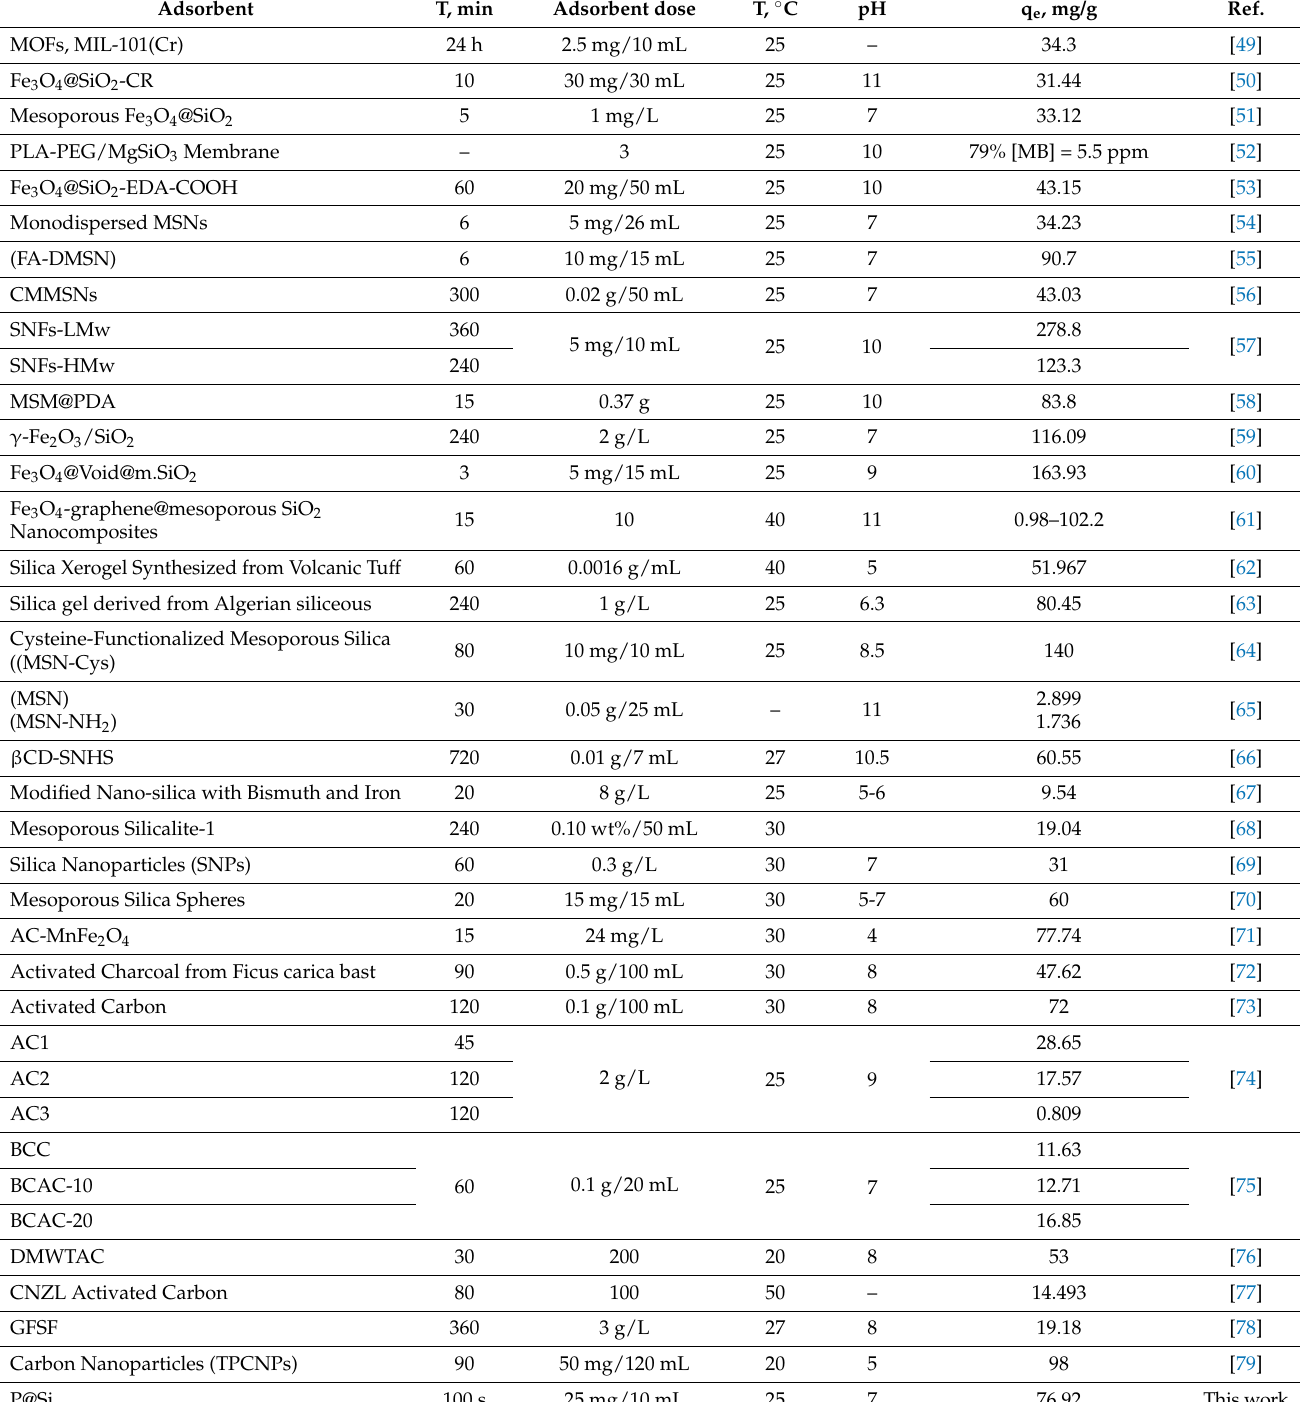
Table 7. Comparison of the maximum adsorption capacities of P@SiO 2 with recently reported SiO 2 -based materials to remove MB dye